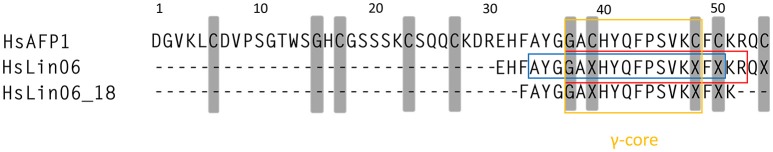
HsAFP1 core regions responsible for prevention of Candida albicans biofilm formation (red box) and synergy with caspofungin (blue box), identified by screening HsLin06-variants (Table 1) for both activities. Both regions are situated within the γ-core of plant defensins (yellow box). Gray regions represent conserved amino acids among plant defensins.